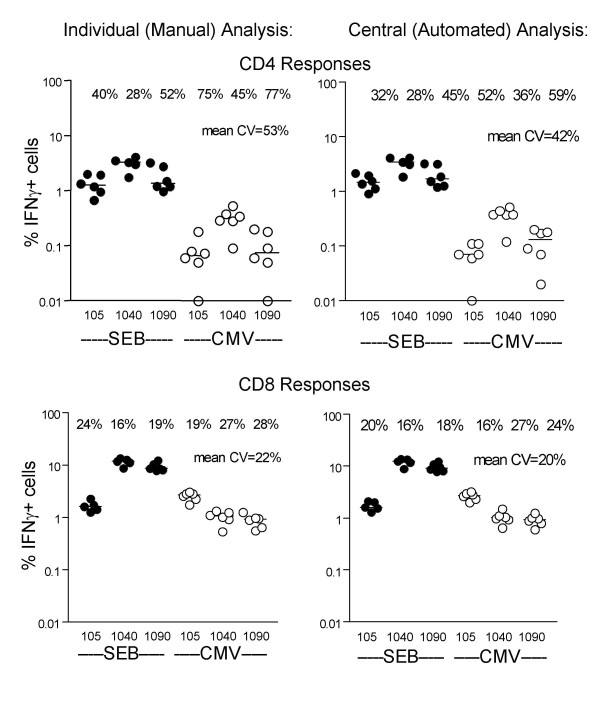
Results of Experiment 2 (shipped whole blood). IFNγ-positive cells in response to SEB or CMV pp65 peptide mix are expressed as a percentage of CD4+ or CD8+ T cells. Results from each site are indicated as a circle, with median responses for each sample (105, 1040, and 1090) indicated by a horizontal bar. The C.V. for each sample is listed across the top of each panel, along with the mean C.V. for that set of samples.